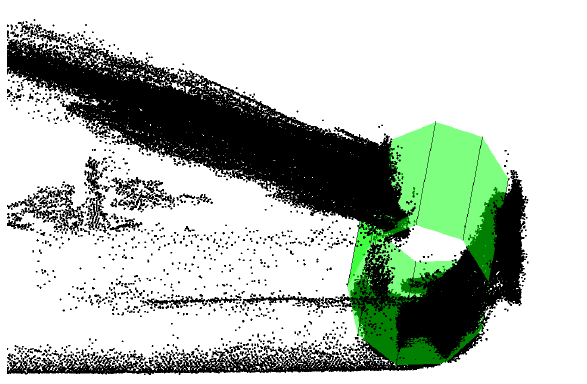
Figure 9: The rain gutter (green) fits well to a cylinder